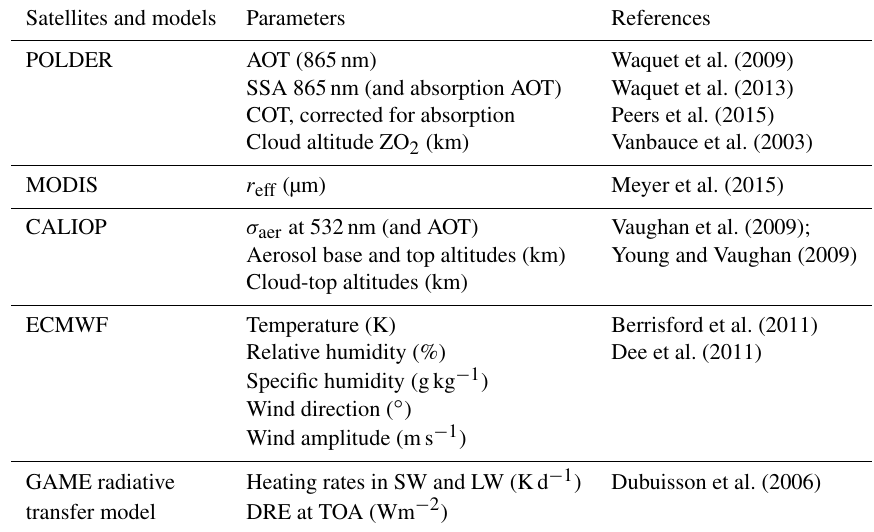
Table 1. Satellites and models and their associated parameters used in this study.